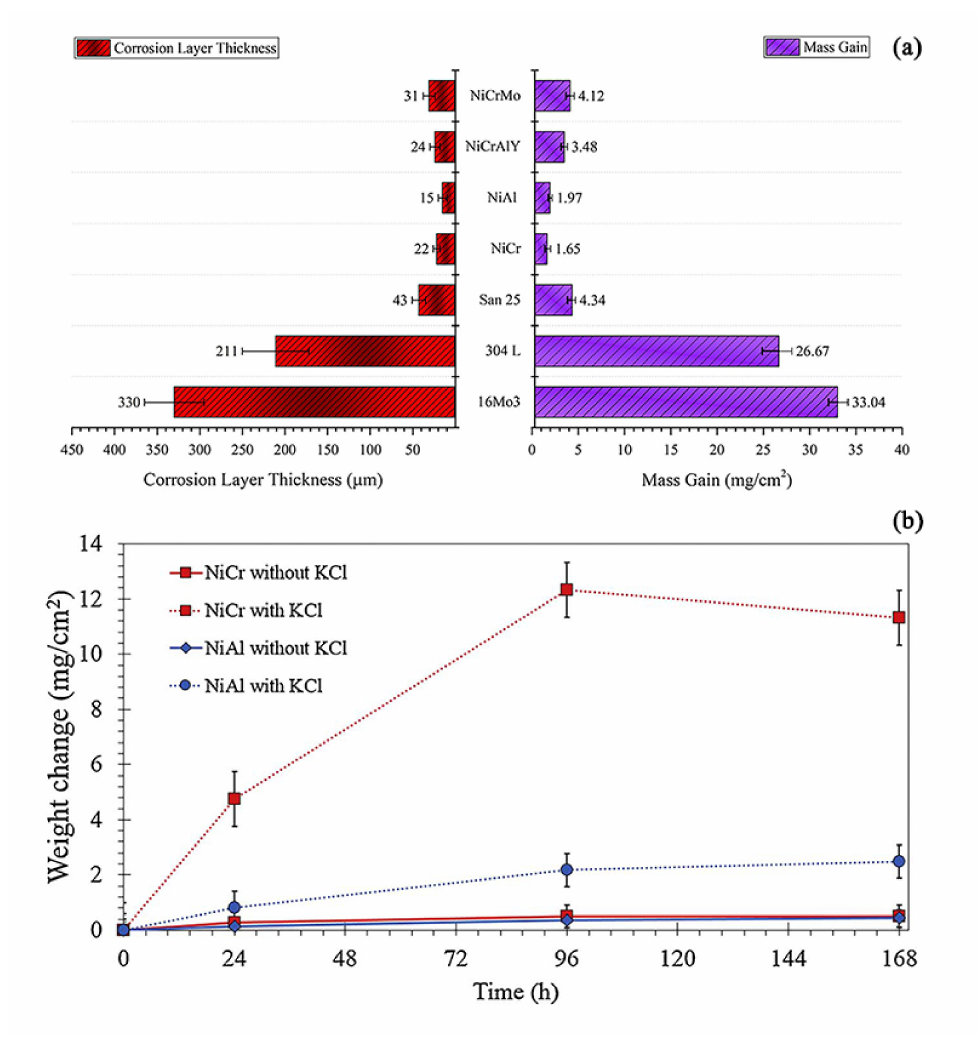
Figure 4. ( a ) Weight gain of the exposed Ni21Cr and NiAl coatings in 5% O 2 + 500 ppm HCl + N 2 up to 168 h at 600 ◦ C with and without KCl deposit [62]. ( b ) The thickness of the formed scale (average of 10 measurements) and mass gain of the samples exposed to KCl deposit at 600 ◦ C for 168 h [58].